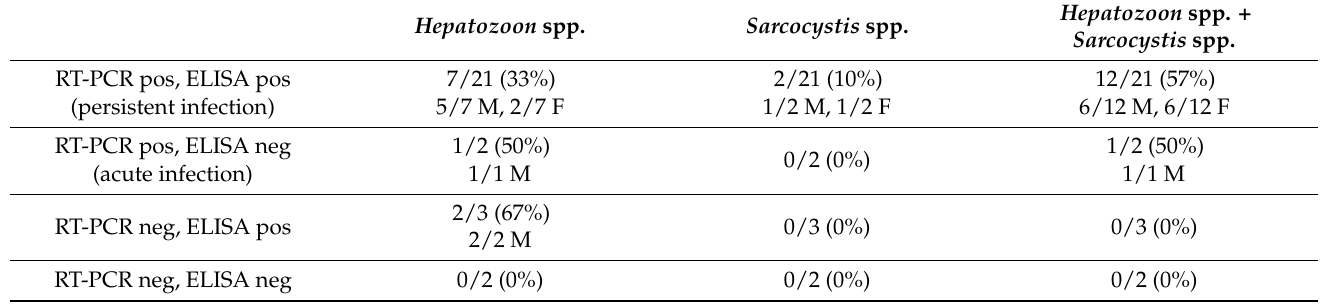
Table 4. Detection of Hepatozoon spp. in the lung or Sarcocystis spp. in the brain or both endoparasites by hematoxylin eosin (H&E) staining in bank voles from OS compared with detection of PUUV RNA by RT-PCR and anti-PUUV antibodies by ELISA.